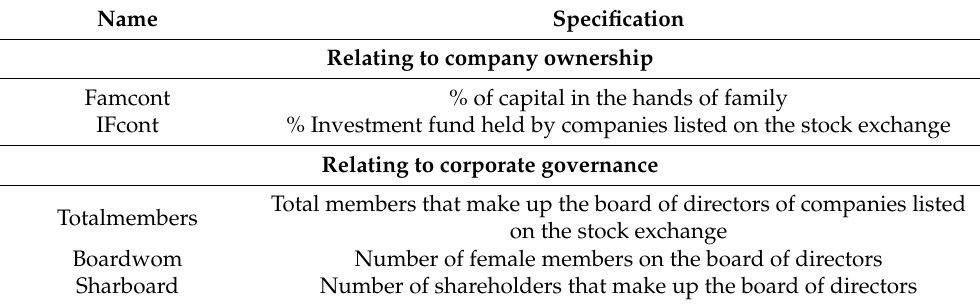
Table 6. Summary of ownership and corporate governance variables.